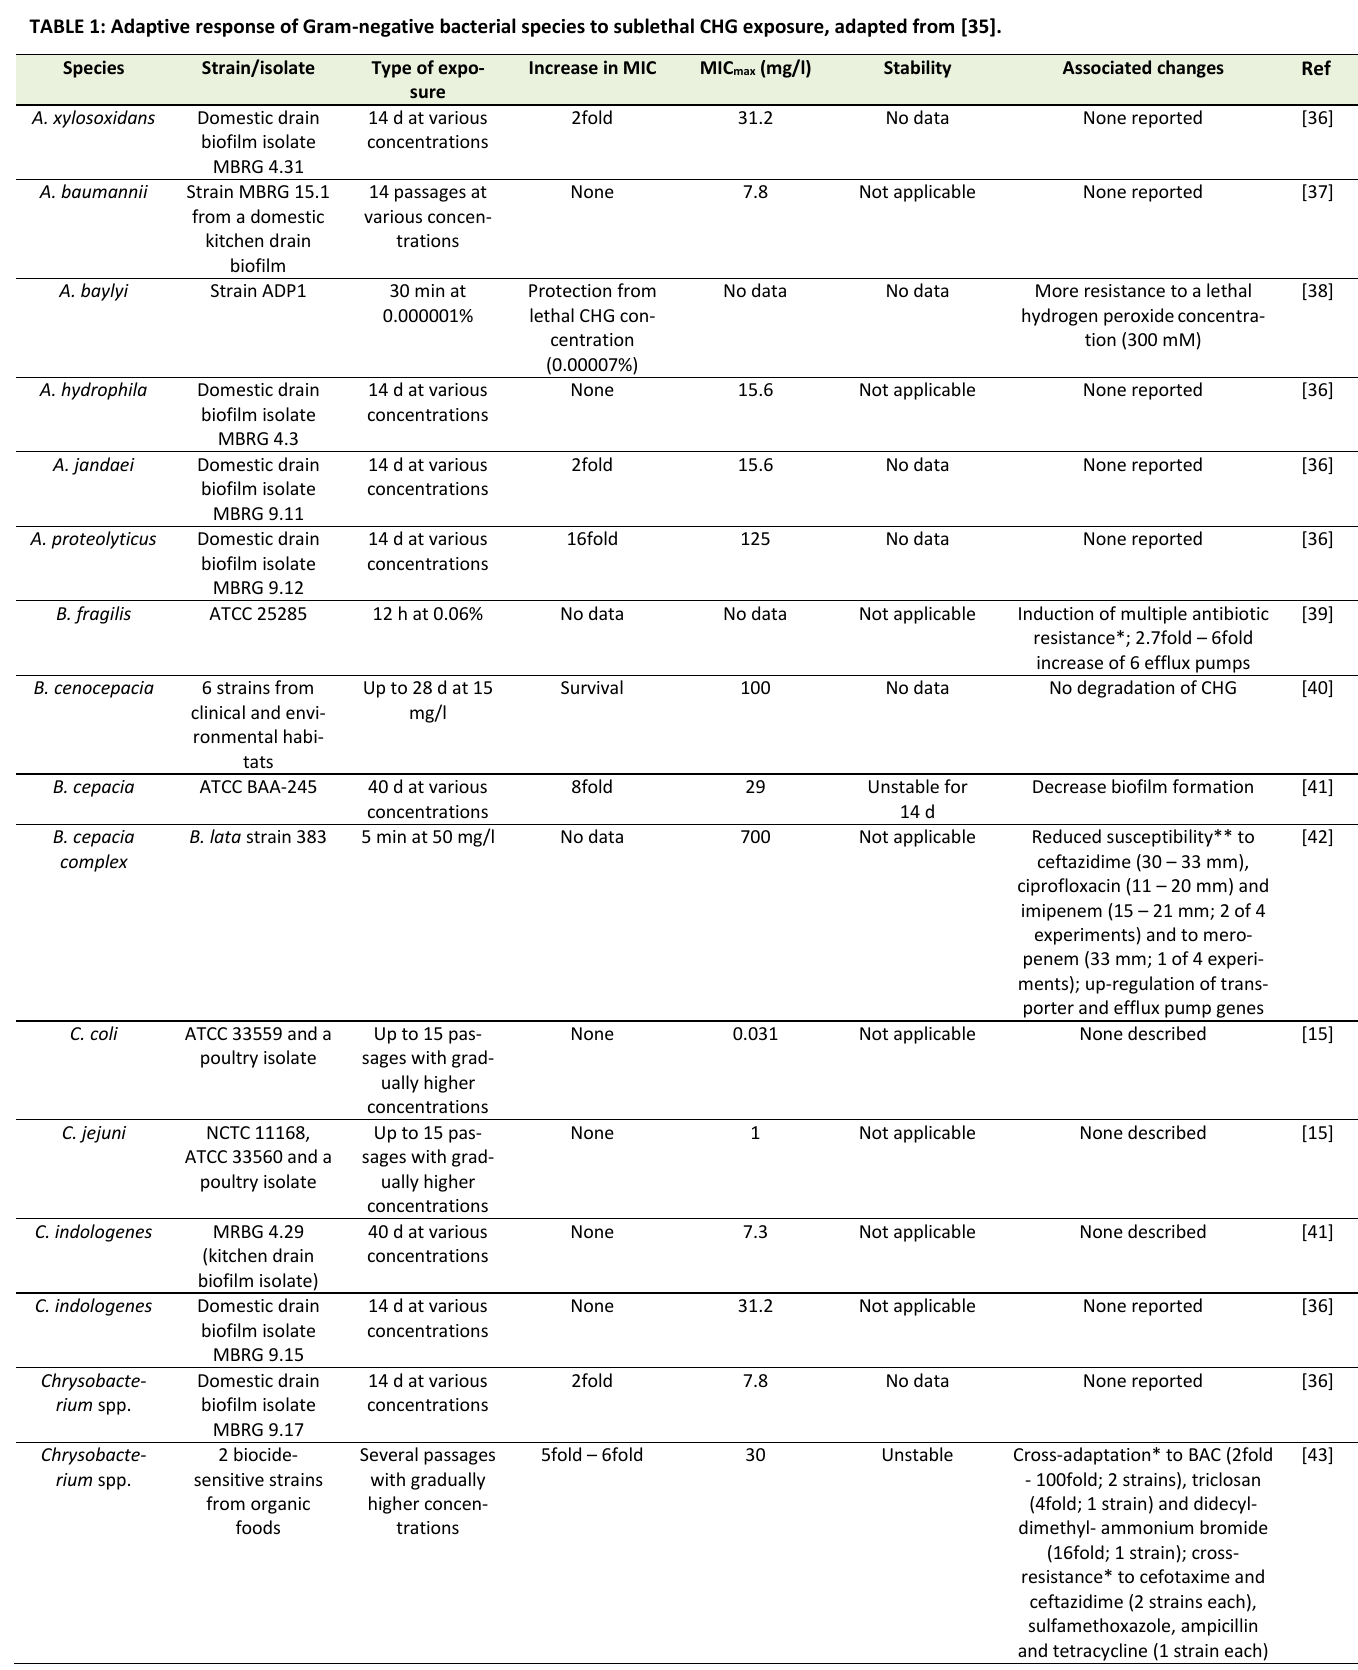
TABLE 1: Adaptive response of Gram-negative bacterial species to sublethal CHG exposure, adapted from [35].